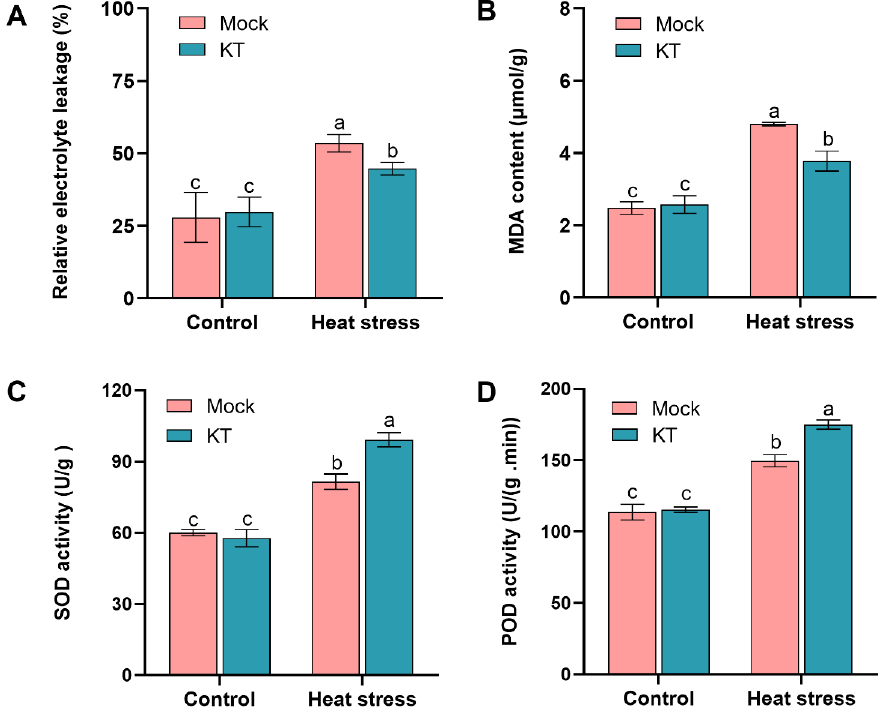
Figure 2. Effect of exogenous KT treatment on membrane lipid peroxidation and antioxidant enzyme activities in rice seedlings under heat stress. Relative electrolyte leakage rate ( A ), malondialdehyde content ( B ), superoxide dismutase activity ( C ), and peroxidase activity ( D ) of 10 − 9 M KT and mock groups after high-temperature treatment at 45 ◦ C. Data are means ± SD. Different lowercase letters show significant differences among treatments analyzed by one-way ANOVA comparison test (n = 3, p < 0.05).